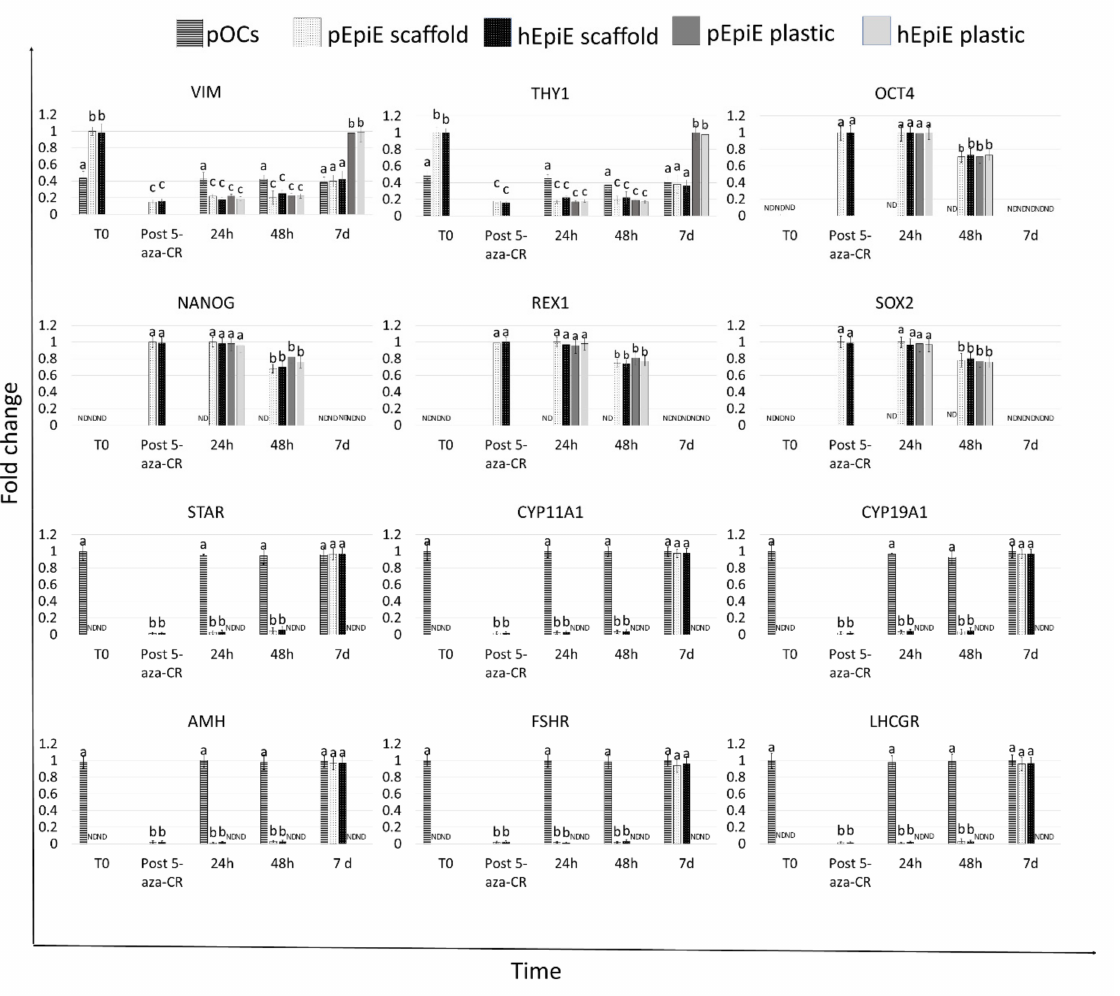
Figure 5. Gene expression changes in pOCs (line bars), pEpiE (white with black dots bars), and hEpiE (black with white dots bars) during the ECM-based scaffold repopulation process. Expression pattern of fibroblast-specific (VIM, and THY1), pluripotency-related (OCT4, NANONG, REX1, and SOX2), and granulosa-cell-associated (STAR, CYP11A1, CYP19A1, AMH, FSHR, and LHCGR) markers in freshly isolated pOCs and porcine and human untreated fibroblasts (T0), in fibroblasts exposed to 5-aza-CR (post 5- aza-CR), and at different time points of ECM-based scaffold repopulation (24 and 48 h and 7 days). (a), (b), and (c) indicate statistically significant differences ( p <